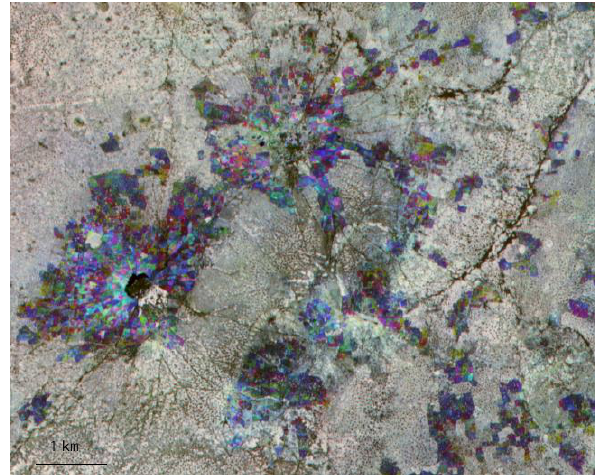
Figure 1 . Example of a 3PTS composite for a village in 2019.